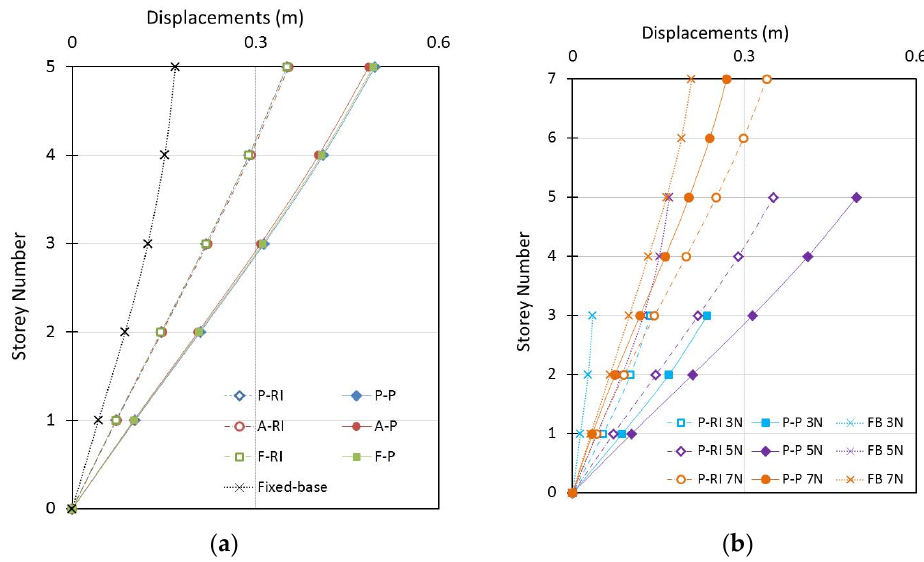
Figure 12. Maximum lateral displacement of the analyzed systems with different support conditions. ( a ) 5-storey Building; ( b ) 3, 5, and 7-storey Buildings.